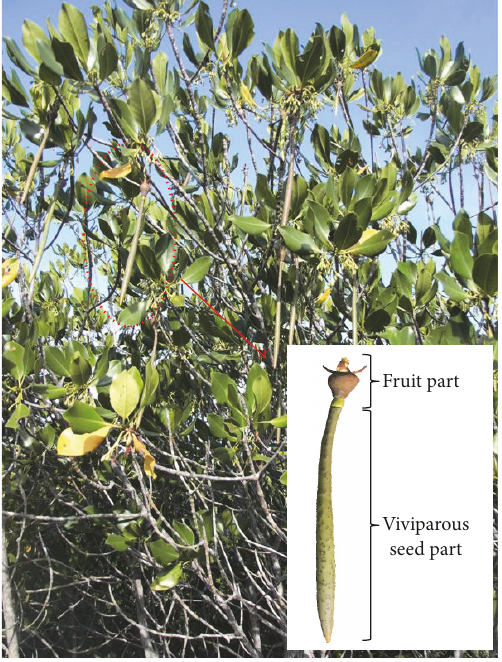
Figure 1: Photographs of Rhizophora stylosa and its seed.